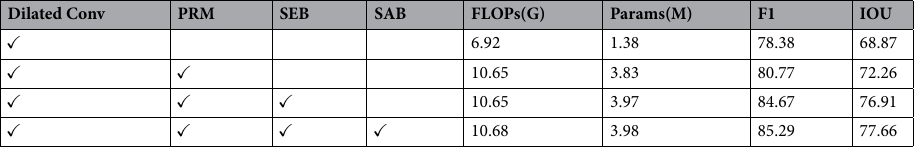
Table 4. Ablation analysis of the individual components of the proposed architecture on the Kvasir dataset. Each of our components contributes differently to the results.